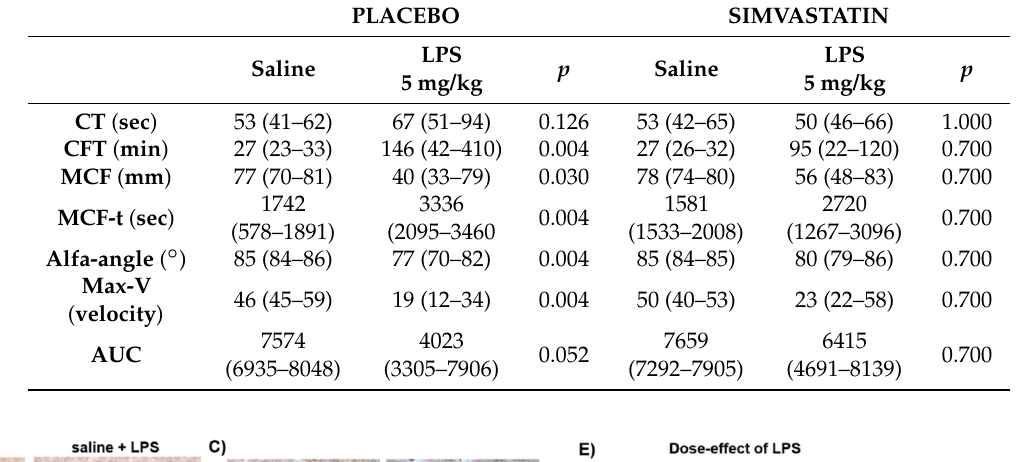
Figure 1. Representative ROTEM graphs showing the effect of LPS vs. saline on the in vitro clot formation in the placebo ( A ) and simvastatin treatment conditions ( B ). CFT, clotting formation time (sec); MCF, maximum clot firmness (units). More details on the curves are provided in Table 1. Table 1. Rotational thromboelastometry (ROTEM©) data on whole blood samples. Comparison of lipopolysaccharide (LPS) vs. saline in placebo and simvastatin (SMV) experimental condition. Results are presented as median (min–max).